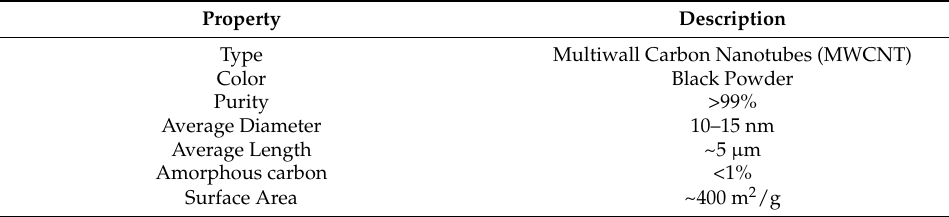
Table 4. Characteristics of MWCNT used in the